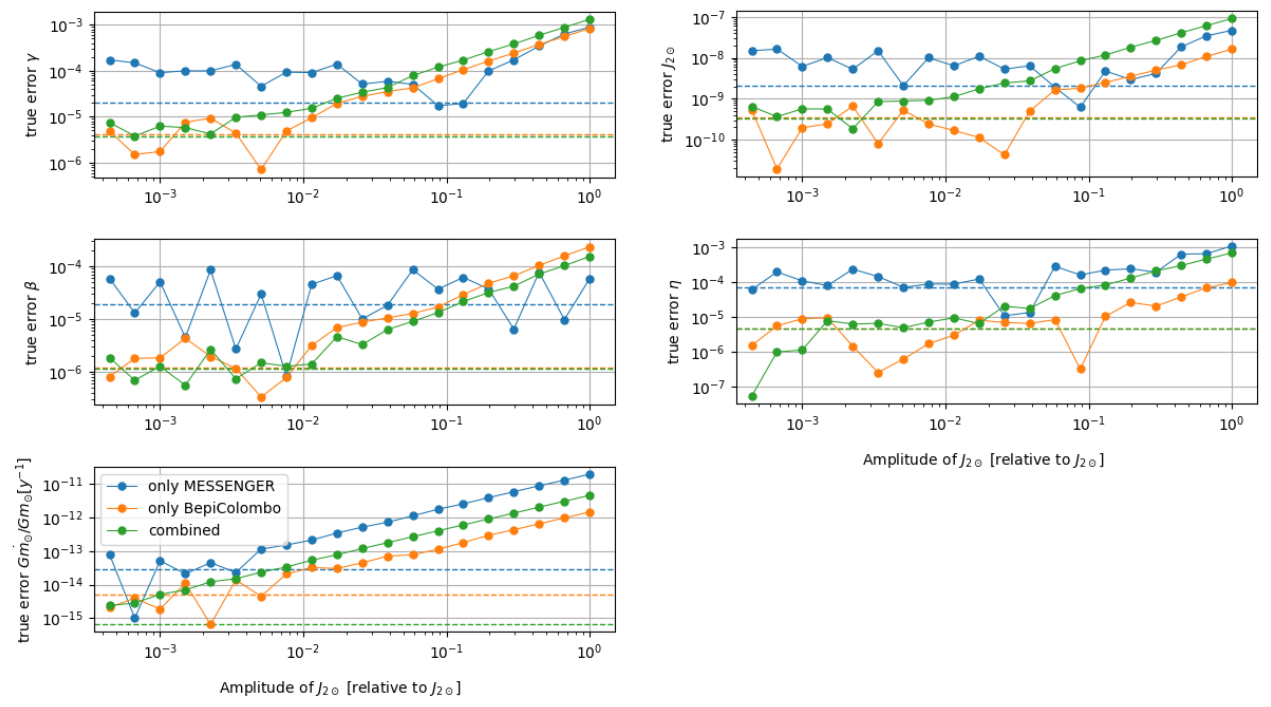
Figure 4. True estimation errors (absolute values) of parameters when not taking into account a dynamic J 2 (cid:12) , versus the amplitude A J taken relative to J 2 (cid:12) , with a priori σ γ = 2.3 × 10 − 5 . The 2 (cid:12) dashed horizontal lines indicate the formal errors, of which the value remains unchanged (up to a relative change of 10 − 5 ) independent of amplitude. In all plots except the one considering ˙ Gm (cid:12) / Gm (cid:12) , the formal errors of only BepiColombo (orange) and combined data (green) are very similar and, therefore, the dashed horizontal lines